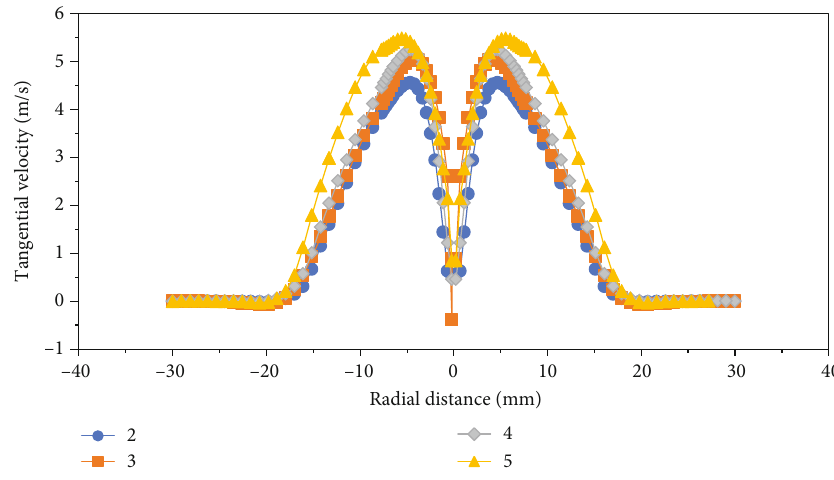
Figure 18: Tangential velocity distribution of di ff erent blade thicknesses in h / d = 8 .